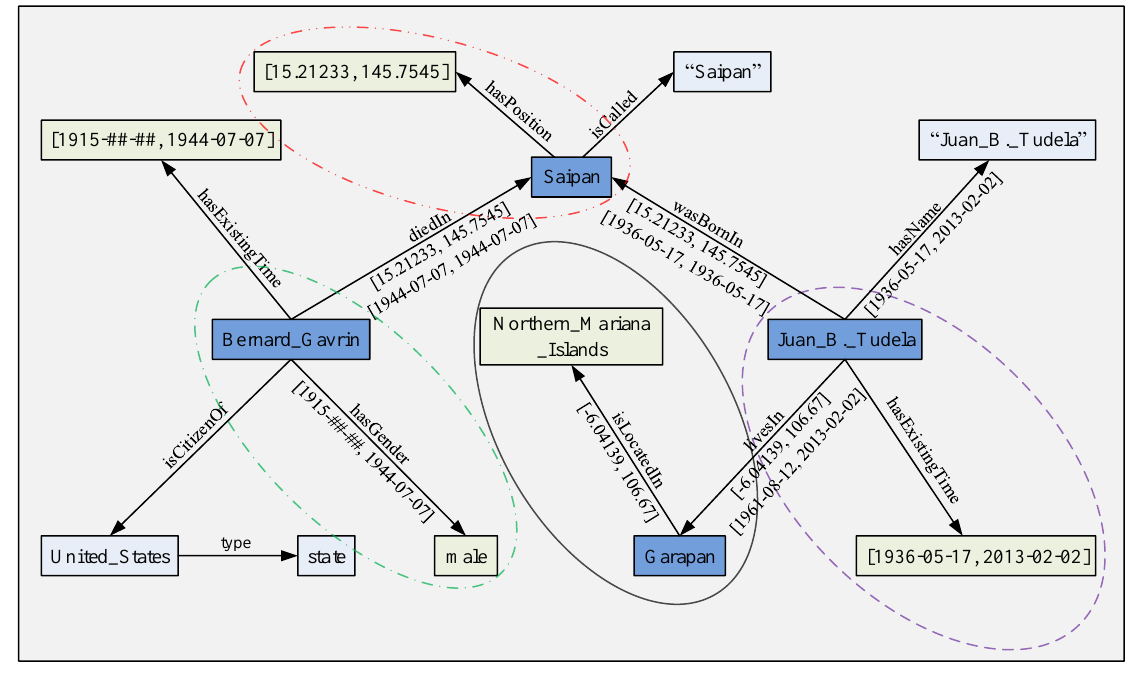
Figure 2. Spatiotemporal RDF data graph.